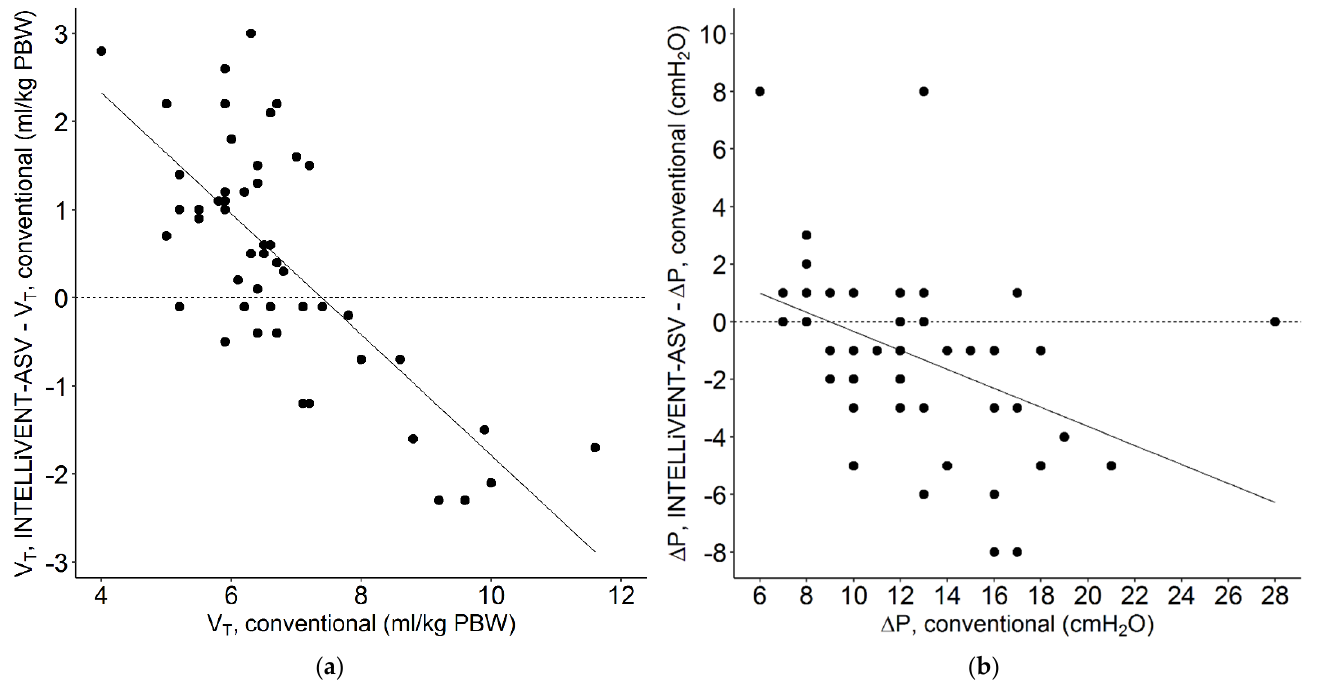
Figure 3. Plot of the relation between V T and Δ P with conventional ventilation at ( a ) 2 and 1 h before conversion to IN- TELLiVENT-ASV, and at ( b ) 1 and 2 h after conversion.